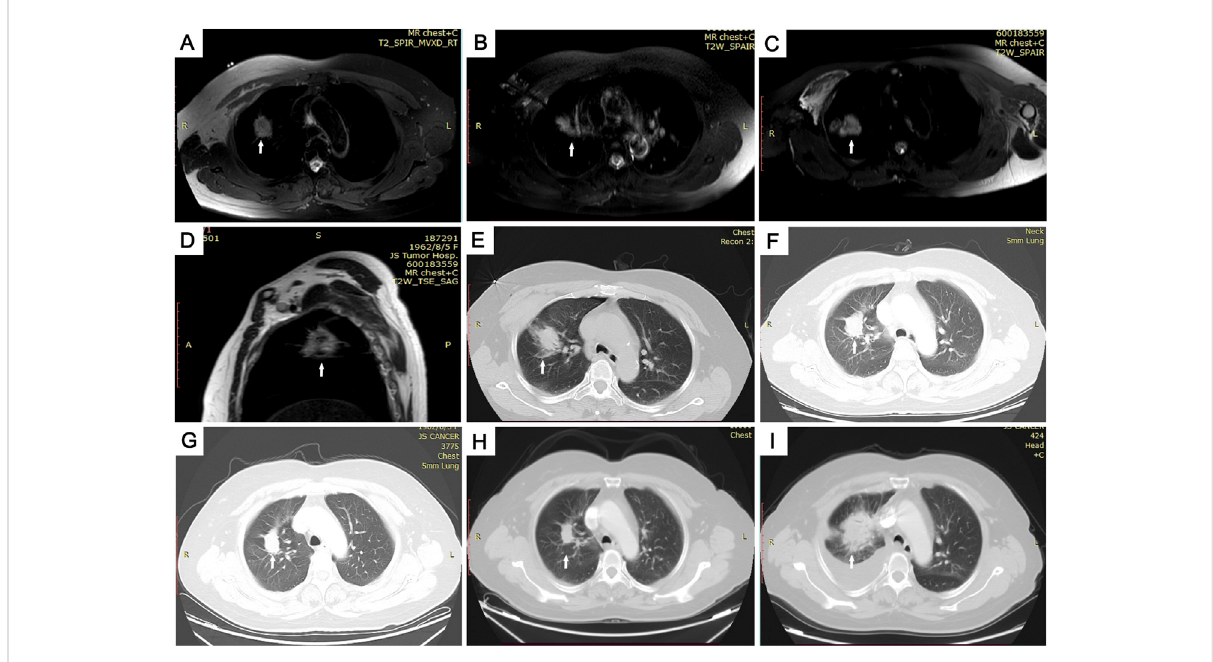
FIGURE 2 Images of the MRI-guided MWA procedure and follow-up in 59-year-old woman with pulmonary adenocarcinoma in superior lobe of right lung. (A) Skin markers were applied to locate the needle insertion site under magnetic resonance imaging (MRI) guidance. (B) Guided by magnetic- resonanceT1WIimage,16G-ablationantennawaspuncturedtothecenterofthetumorlesion. (C – E) Aftertwo8-minablationcycles,weachieveda satisfactory ablation area, which is clearly seen in axial- (C) and sagittal- (D) phase images, and a large area of ground glass covers the entire tumoronthelungwindowofCT I . (F – I) Computedtomography(CT)imagesoffollow-up.Follow-upCTscansat3 (F) ,6 (G) ,and12 (H) monthsshow signi fi cantly shrinking, and follow-up CT scan at 21 months (I) showed the tumor had increased in